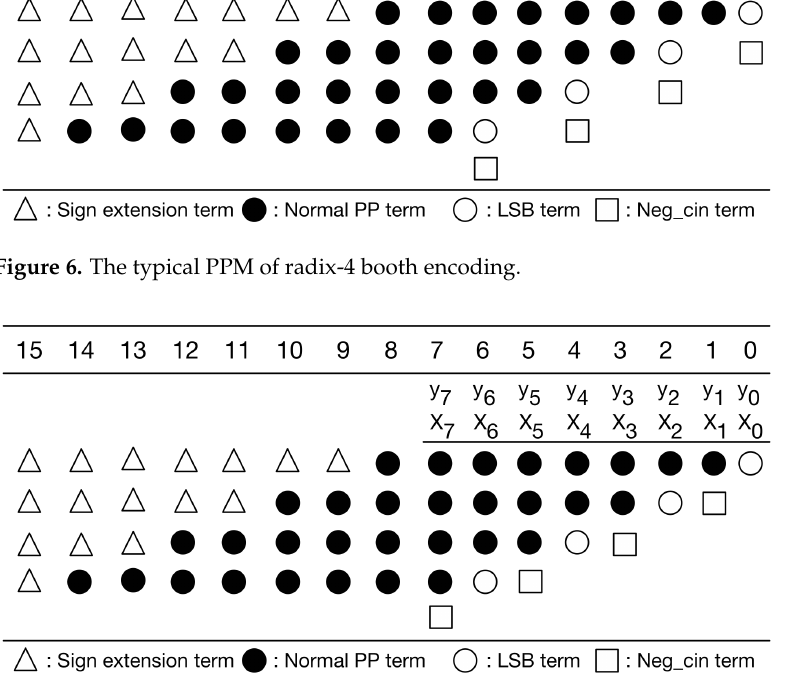
Figure 7. The modified PPM of radix-4 booth